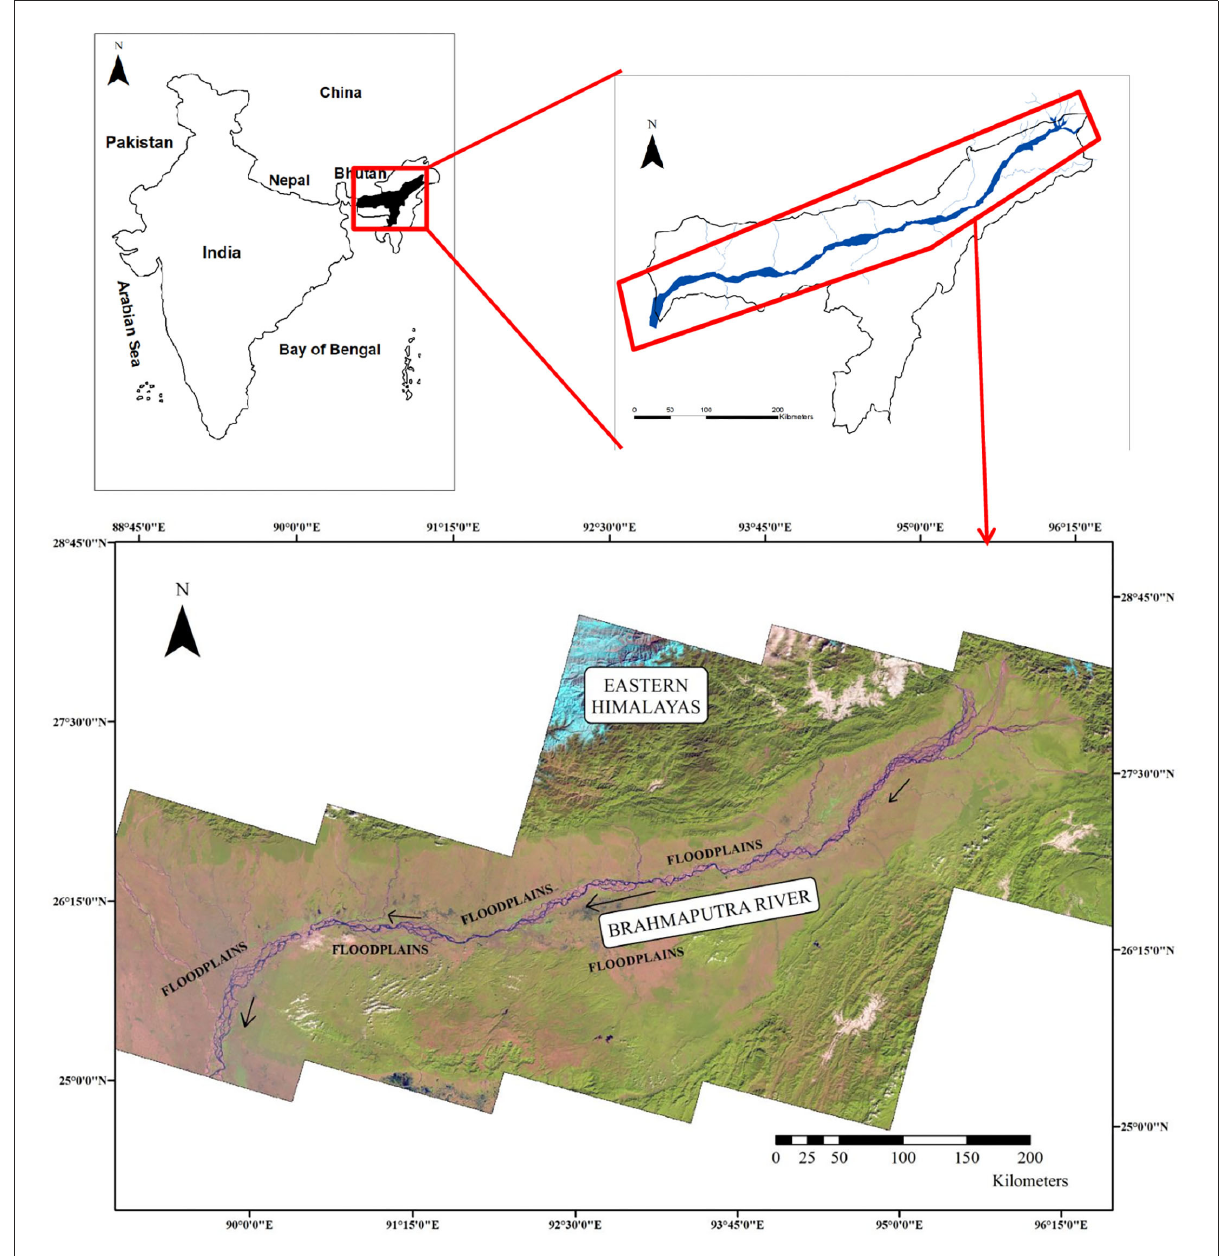
FIGURE1 Location map of the study area highlighting the Brahmaputra floodplain (BFP).